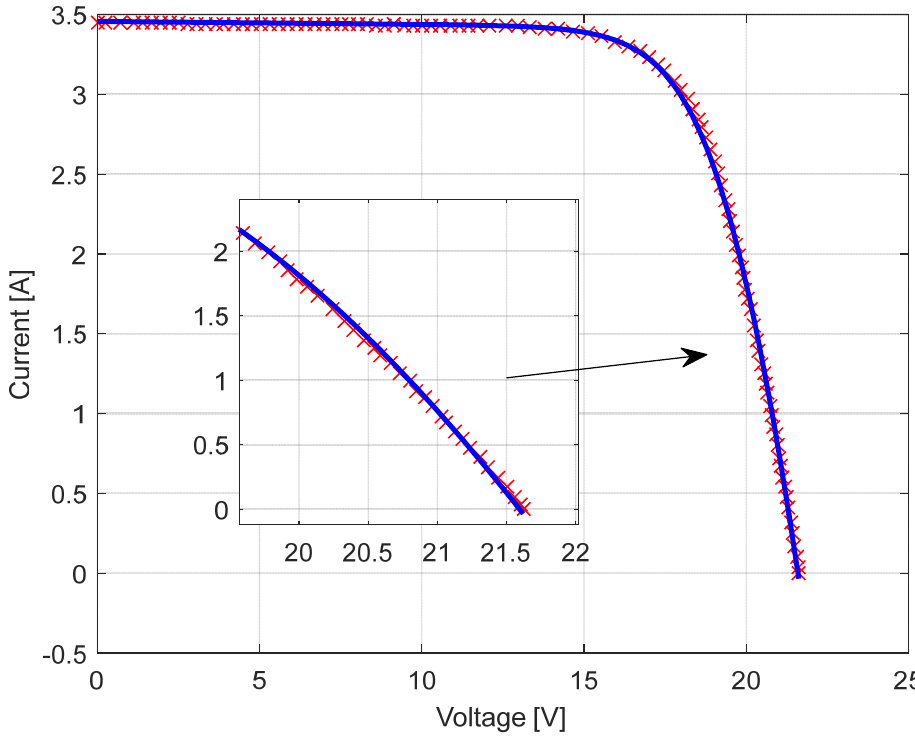
Figure 14. Current-voltage characteristics at 1000 W/m 2 and 25 °C.